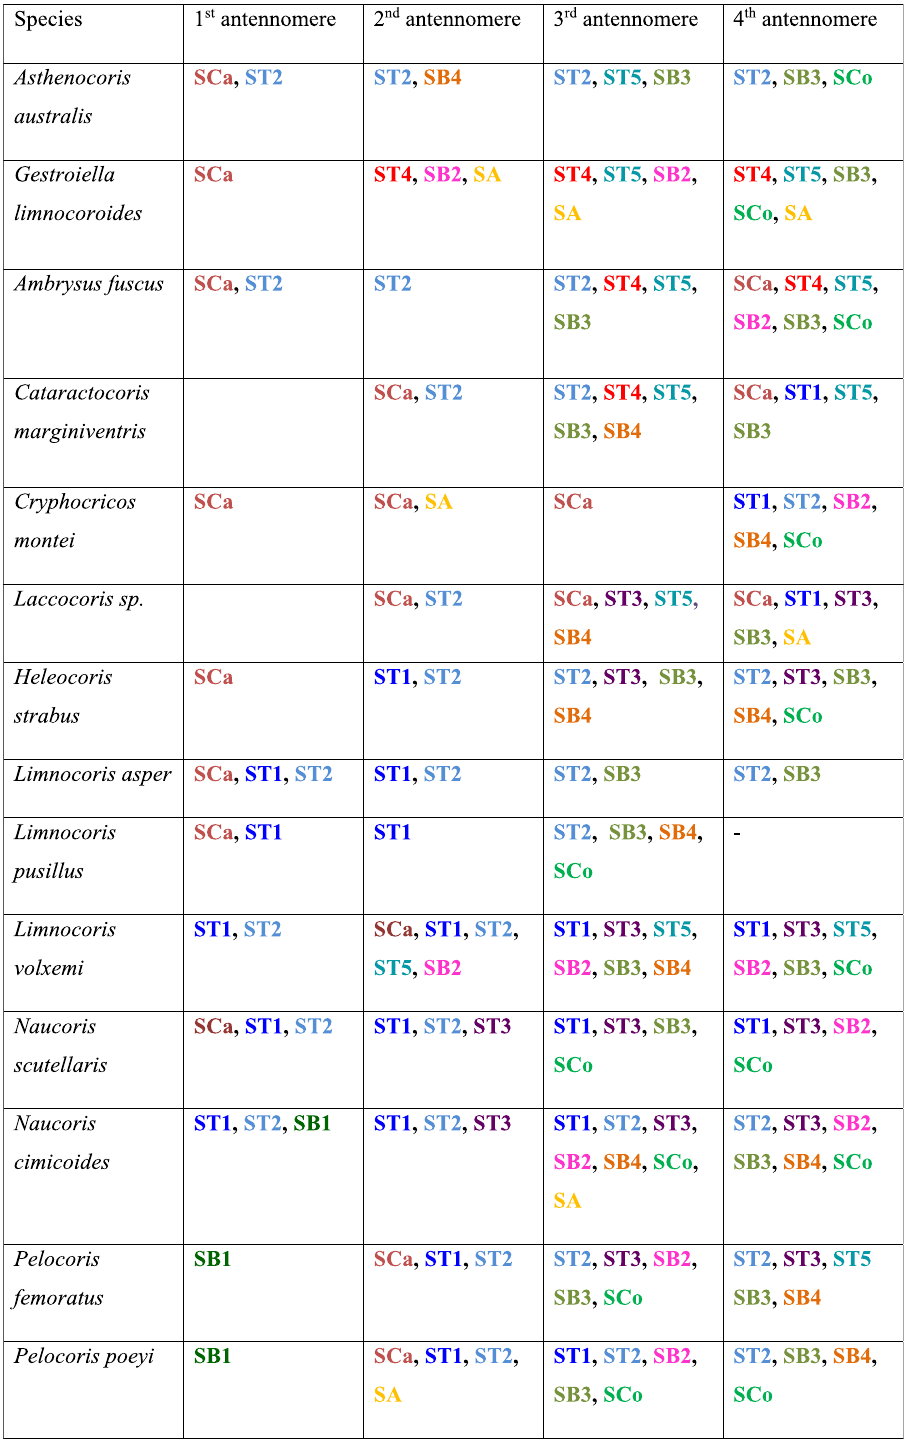
Table 2. Distribution of sensilla types on the antennomeres (the colours correspond to the ones used in Figs. 5, 6, 7, 8 and